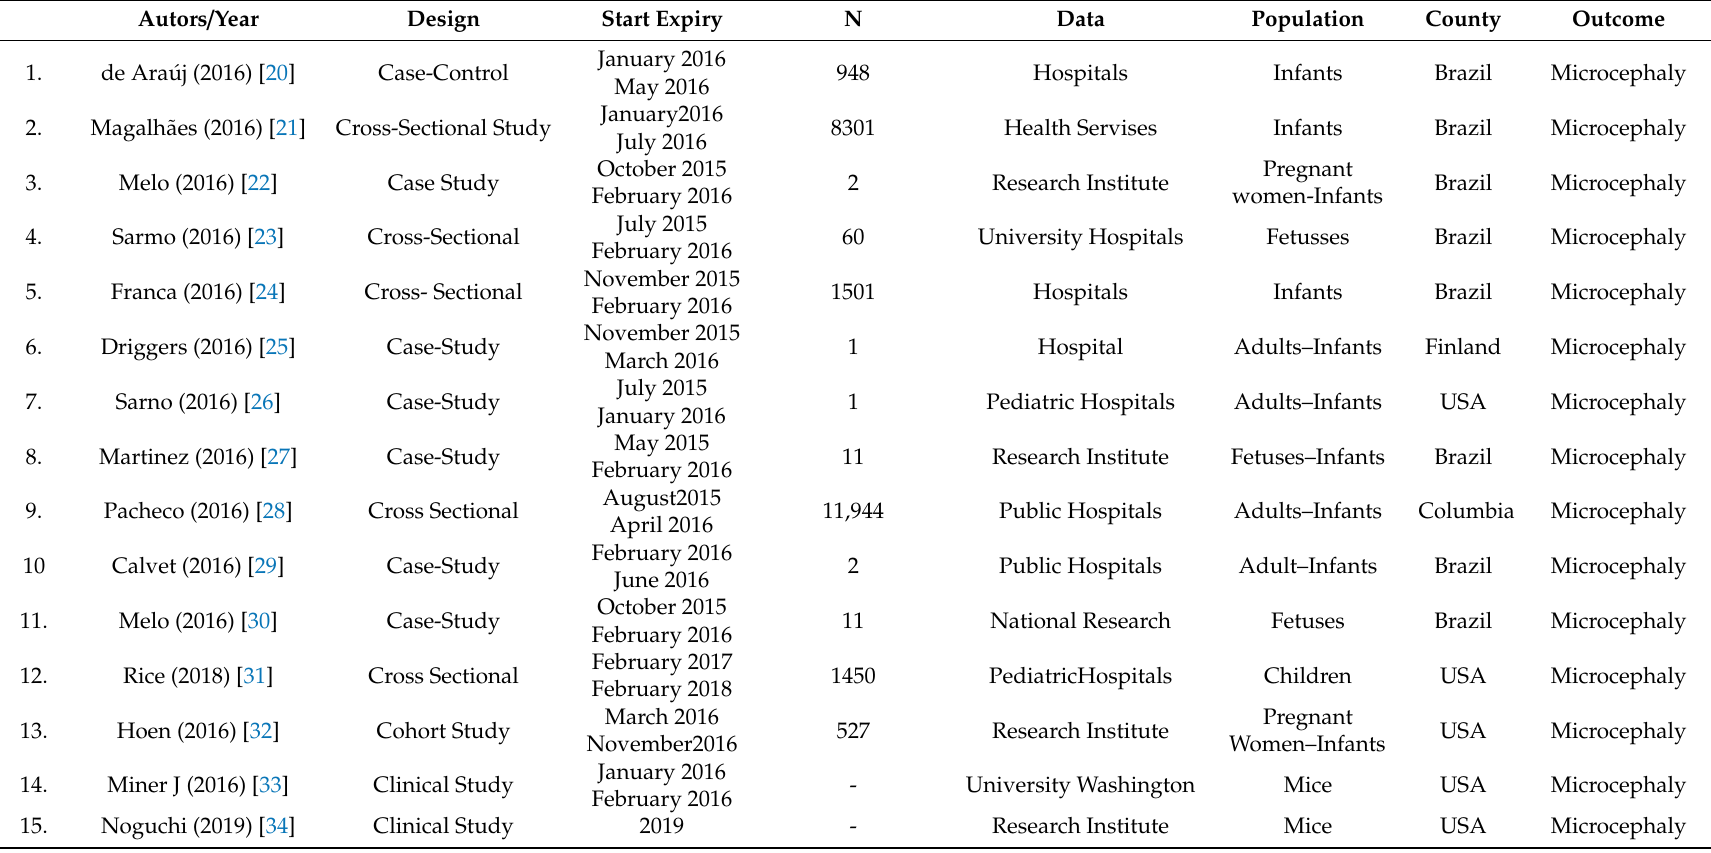
Table 2. Included in the